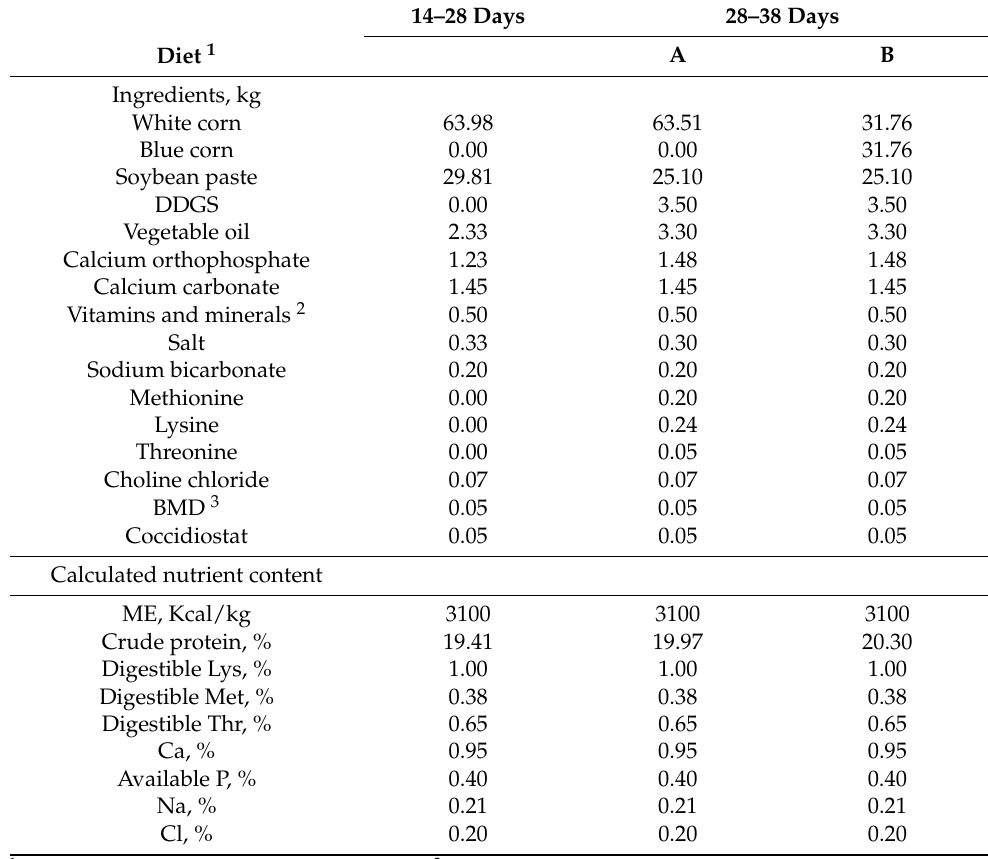
Table 1. Ingredient composition of the basal